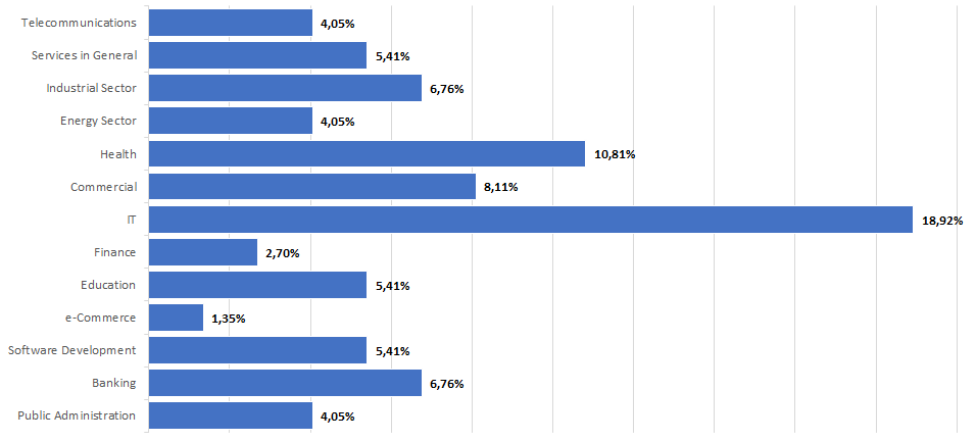
Fig. 1 . Sectors in which the proposals are applied